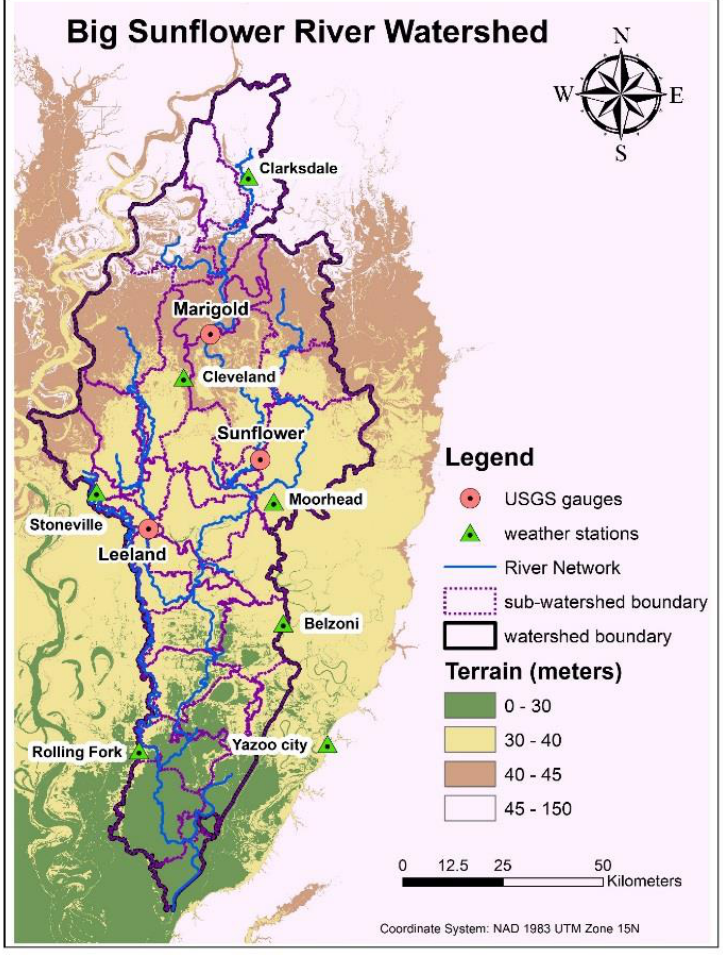
Figure 1. Study area: Big Sunflower River Watershed in Mississippi, its sub-watersheds, river network, USGS gauges, and weather stations .